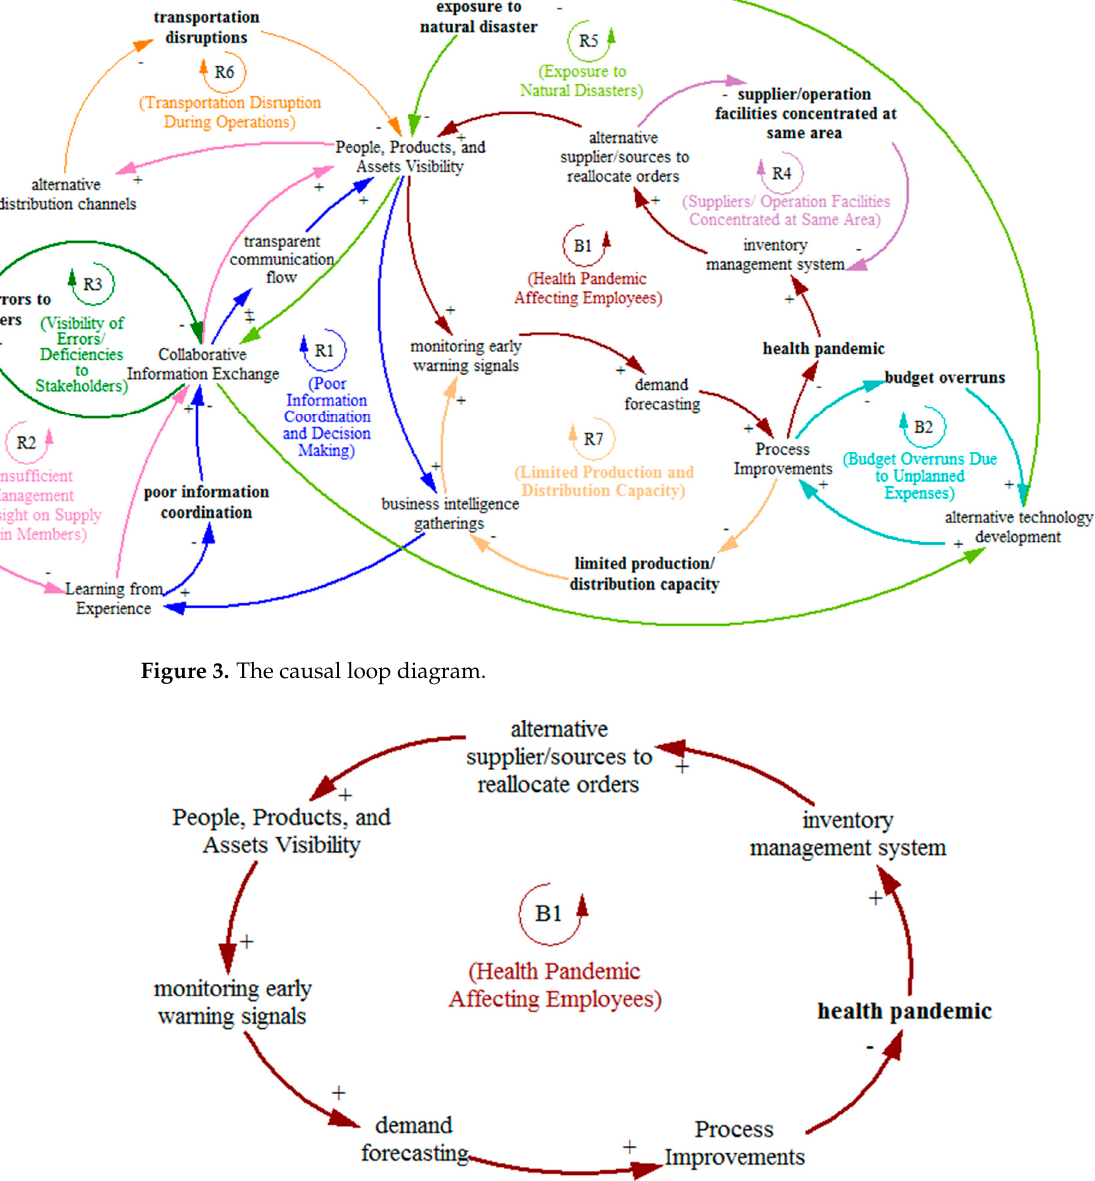
Figure 5. Balancing loop B2 (budget overruns due to unplanned expenses). 4.3. Reinforcing Loop R1 (Poor Information Coordination and Decision Making) The reinforcing loop R1 in Figure 6 shows that poor information coordination and decision making is caused by the decrease in collaborative information exchange among stakeholders. This decrease in information exchange reduces the transparent communica- tion flow of an organization, both externally and internally. The transparent communica- tion flow decreases the visibility of people, products, and assets and decreases awareness of future trends and practices collected through business intelligence gatherings. Further, business intelligence can be gained through experience, thus decreasing poor information coordination and decision making.